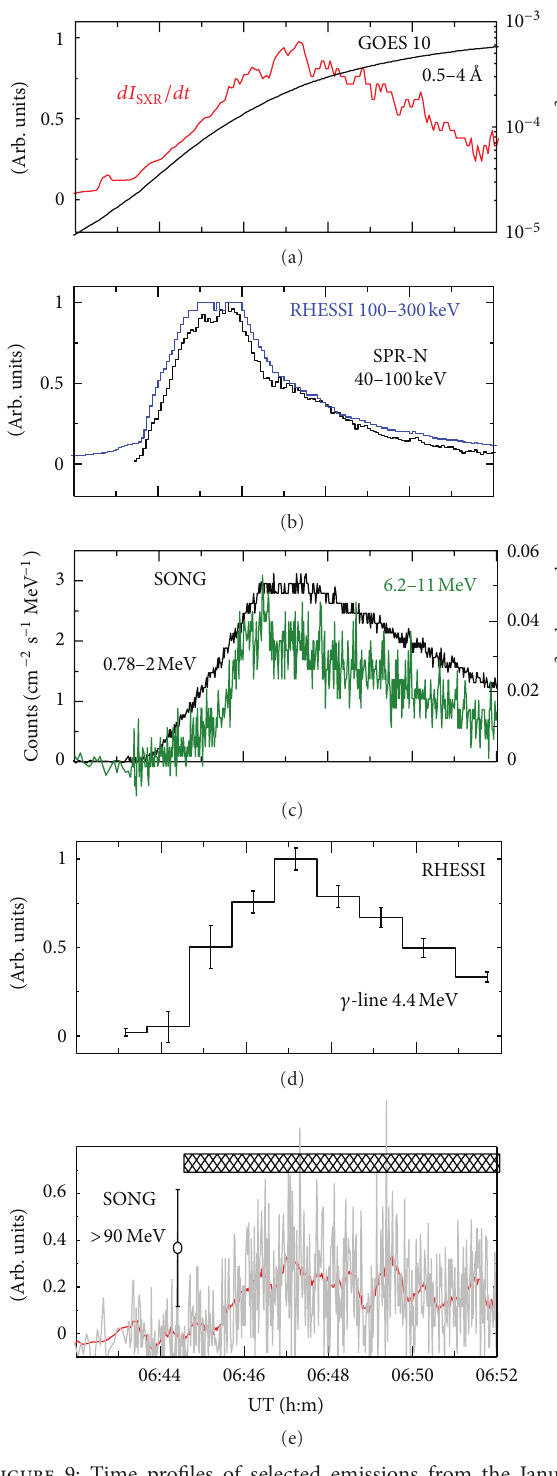
Figure 9: Time profiles of selected emissions from the January 20, 2005, flare: (a) soft X-ray flux (black curve) and its derivative (red curve); (b) hard X-rays (SPR-N and RHESSI, arbitrary units); (c) gamma-rays 0.78–2 MeV (black, left 𝑦 -axis) and 6.2–11MeV (green, right 𝑦 -axis) from SONG; (d) the 4.4MeV gamma line from RHESSI, courtesy G. Share; (e) high-energy gamma-rays (SONG). Red curve in the bottom panel presents smoothed data on gamma-